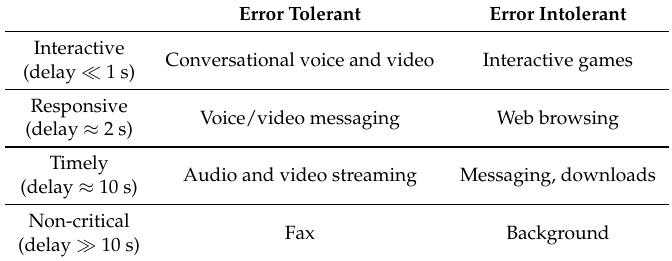
Table 3. Quality of Service (QoS) criteria for classification of multimedia